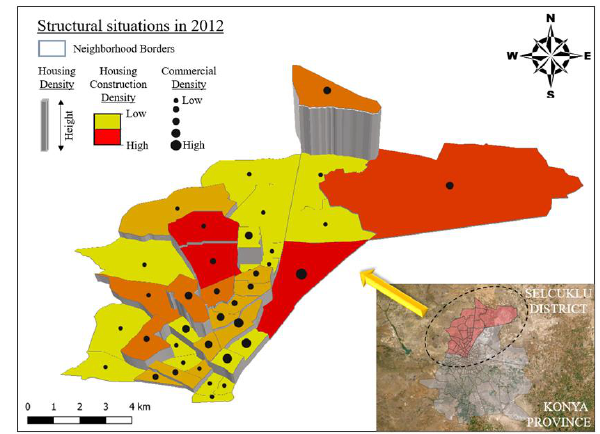
Figure 7. Spatial distribution of Structural data for